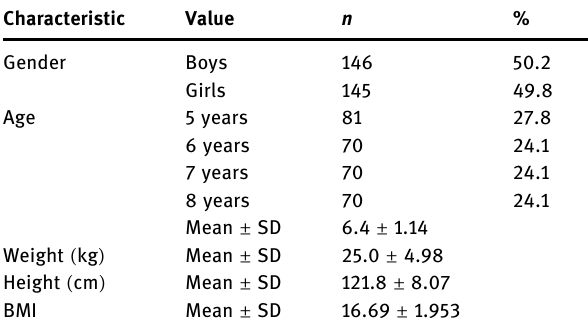
Table 1: Characteristics of